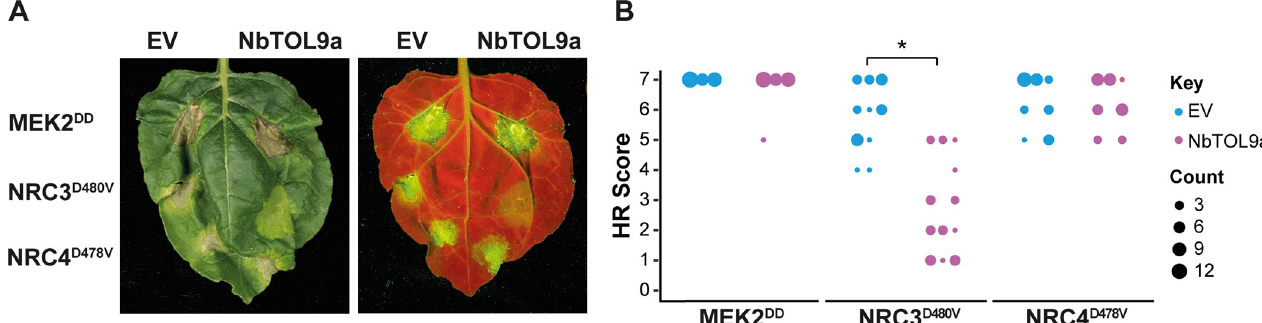
Fig 11. Overexpression of NbTOL9a suppresses autoactive NRC3 D480V but not MEK2 DD or NRC4 D478V . (A) Photo of representative N . benthamiana leaves showing HR after coexpression of EV and NbTOL9a (labelled above leaf panels) with MEK2 DD , NRC3 D480V , and NRC4 D478V . HR response was scored and photographed 5 days after agroinfiltration (left panel under white light, right panel autofluorescence under UV light). MEK2 DD was included as a positive control for cell death (S11 Data). (B) HR results are presented as dot plots, where the size of each dot is proportional to the number of samples with the same score (count). Three biological replicates were completed, indicated by columns for EV, NbTOL9a in each treatment (MEK2 DD , NRC3 D480V , NRC4 D478V ). Statistical tests were implemented using the besthr R library [41]. We performed bootstrap resampling tests using a lower significance cutoff of 0.025 and an upper cutoff of 0.975. Mean ranks of test samples falling outside of these cutoffs in the control samples bootstrap population were considered significant. Significant differences between the conditions are indicated with an asterisk ( � ). Details of statistical analysis are presented in (S15 Fig). EV, empty vector; HR, hypersensitive